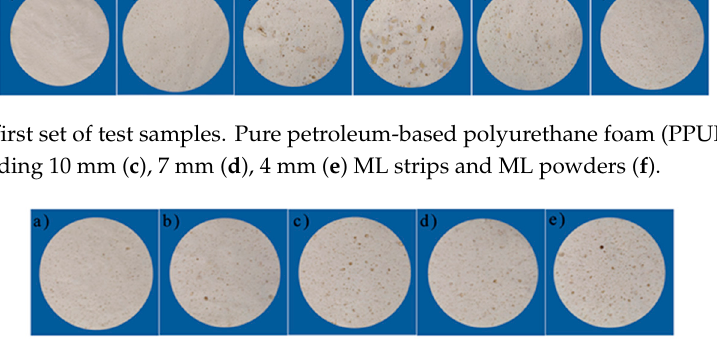
Figure 4. The second set of test samples. TOPUF adding 0.3 wt% ( a ), 0.6 wt% ( b ), 0.9 wt% ( c ), 1.2 wt% ( d ) and 1.5 wt% ( e ) ML powders.